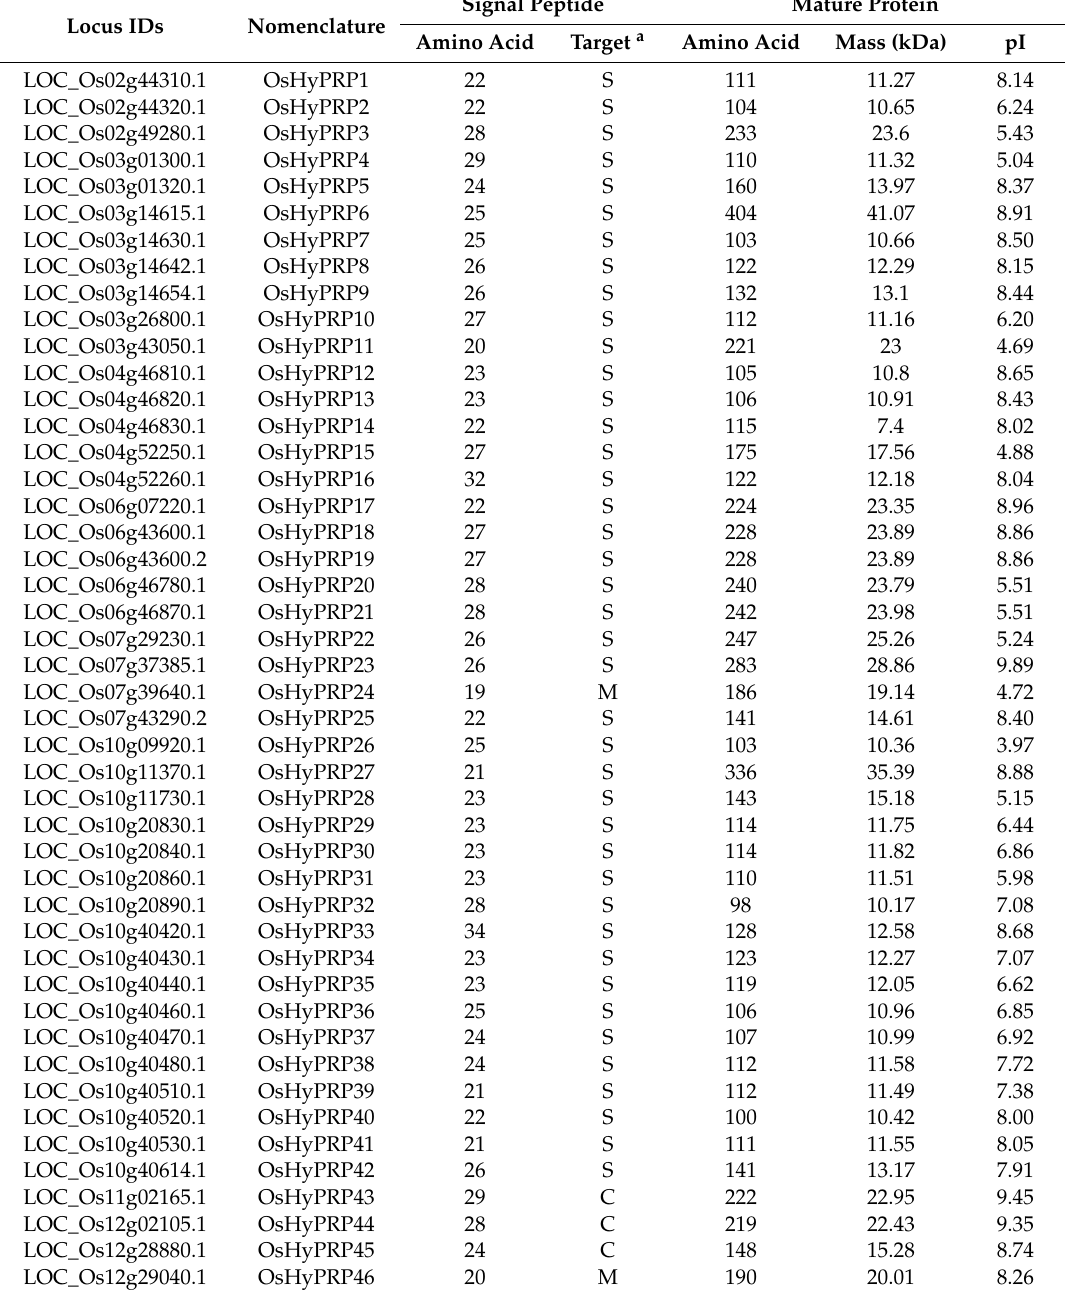
Table 1. List of Hybrid proline-rich proteins (HyPRPs) in rice and some of their features. Locus